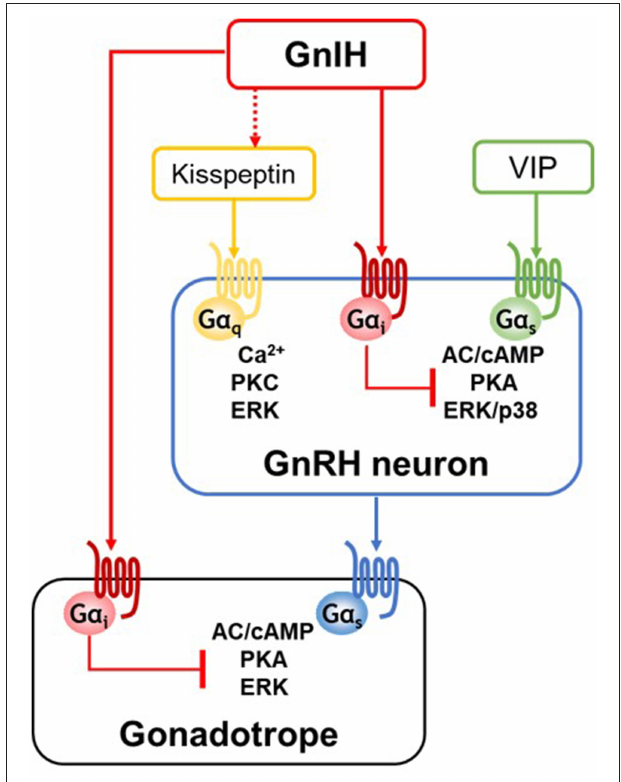
FIGURE 1 | A schematic representation of GnIH action at the hypothalamic-pituitary levels. GnIH neurons project to hypothalamic GnRH neurons and pituitary gonadotropes, and GnIH directly acts via G α i -coupled GPR147 or GPR74 expressed in its target cells. GnRH neurons are activated by kisspeptin or vasoactive intestine peptide (VIP) stimulation. GnIH has no direct inhibitory effect on kisspeptin/G α q -coupled GPR54-induced Ca 2 + or PKC pathway. Although kisspeptin/GPR54 pathway is not the direct target of GnIH action, GnIH may regulate kisspeptin neuronal activity via direct fiber contact and GnIH receptor expressed in kisspeptin neurons. On the other hands, GnIH effectively inhibits VIP/G α s -coupled VPAC2-induced pathway by specifically acting on adenylate cyclase (AC)/cAMP/protein kinase A (PKA)-dependent pathway. In gonadotropes, GnIH exerts its inhibitory effect via AC/cAMP/PKA pathway, thus G α s -coupled GnRH receptor signaling is specifically inhibited by